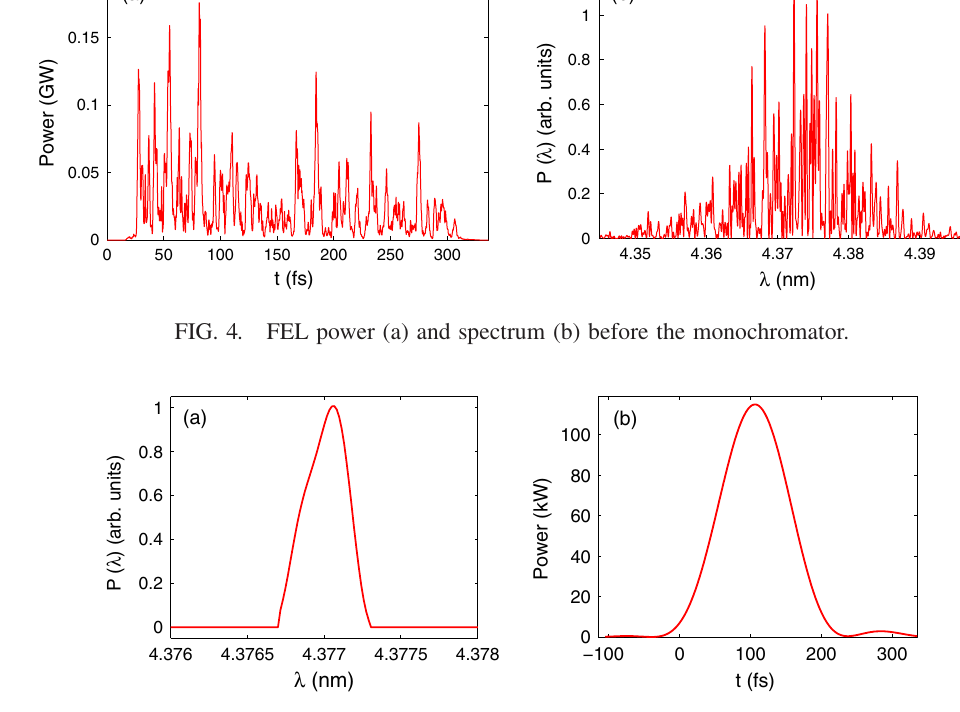
FIG. 5. FEL spectrum (a) and power (b) after the monochromator.